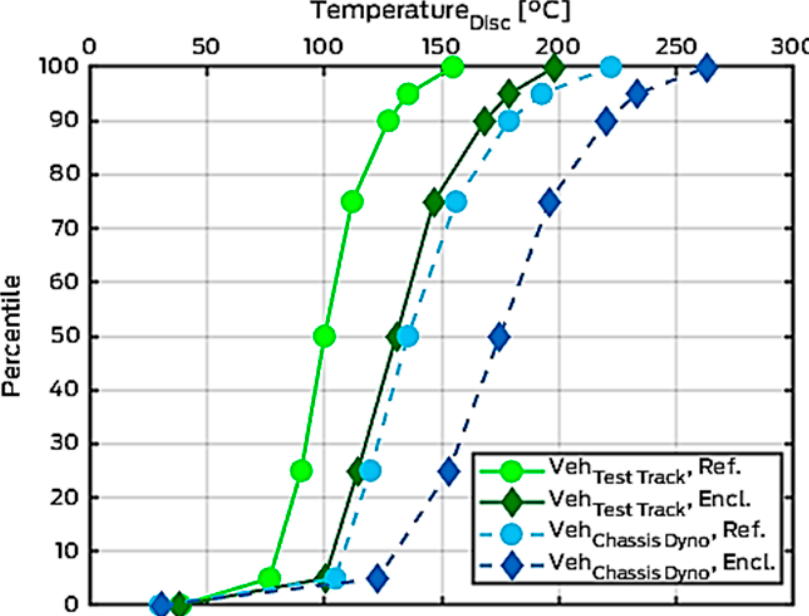
Figure 3. Brake disc temperatures recorded by sliding thermocouples at the front right wheel (enclosed) and at the front left wheel (reference/unmodified) during 3h-LACT cycle on the test track and on the chassis dynamometer.